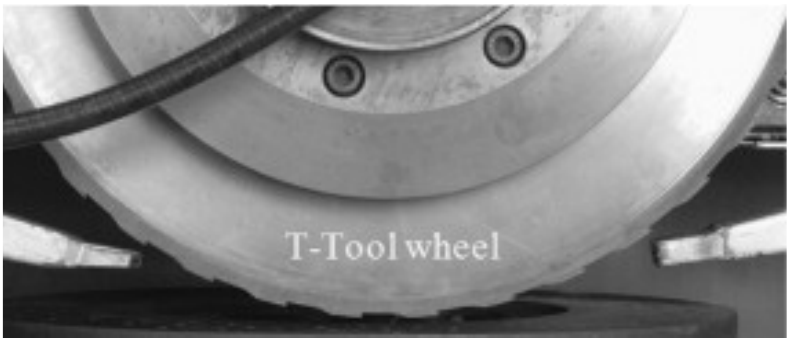
Figure 18. A segmented grinding wheel [104].